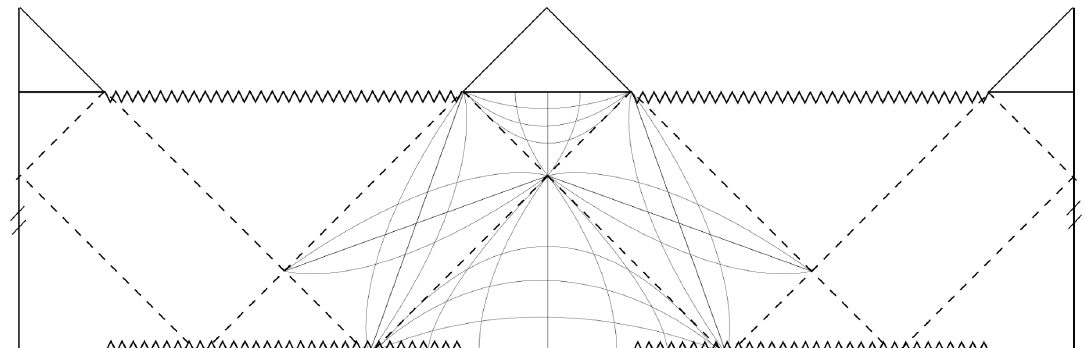
Figure 2. The lines in this diagram illustrate constant ˜ η and ˜ χ